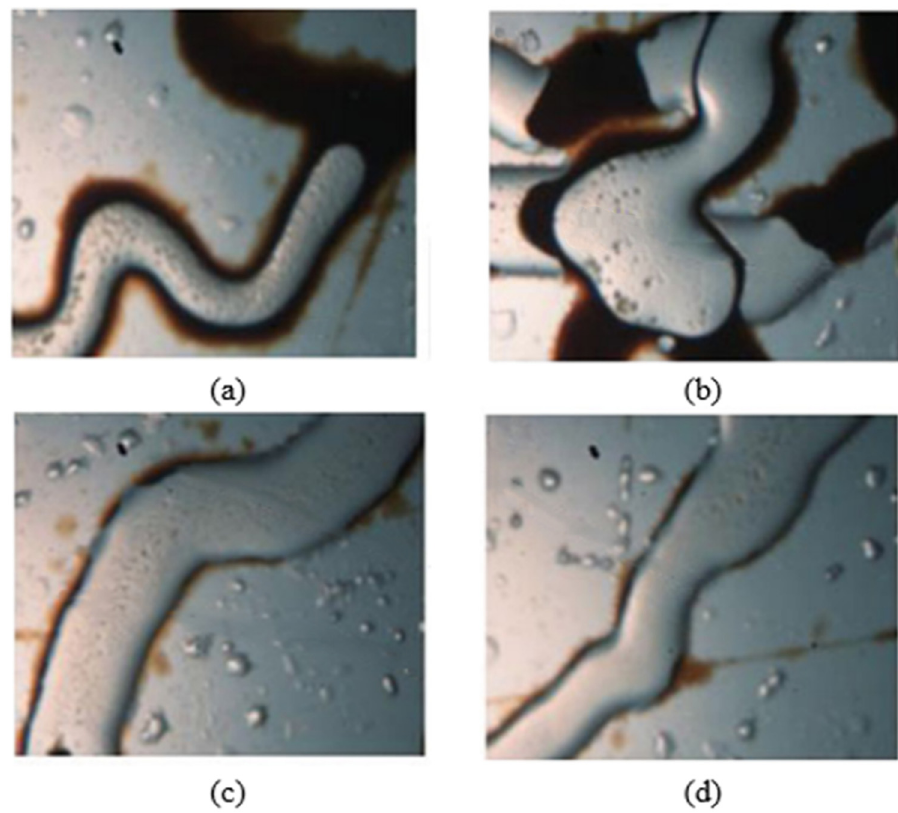
Figure 5: Pore scale visualization of wettability, oil ( brown ) , and solution ( white ) : ( a ) oil fi lms on the wall of throats show an oil - wet porous medium, ( b ) trapped polymers in pores and throats show an oil - wet porous medium, ( c ) partial remained oil due to incomplete silica adsorption onto medium surface, ( d ) absence of oil fi lms shows water - wetting property in throats after DSNP solution fl ooding [ 143 ]